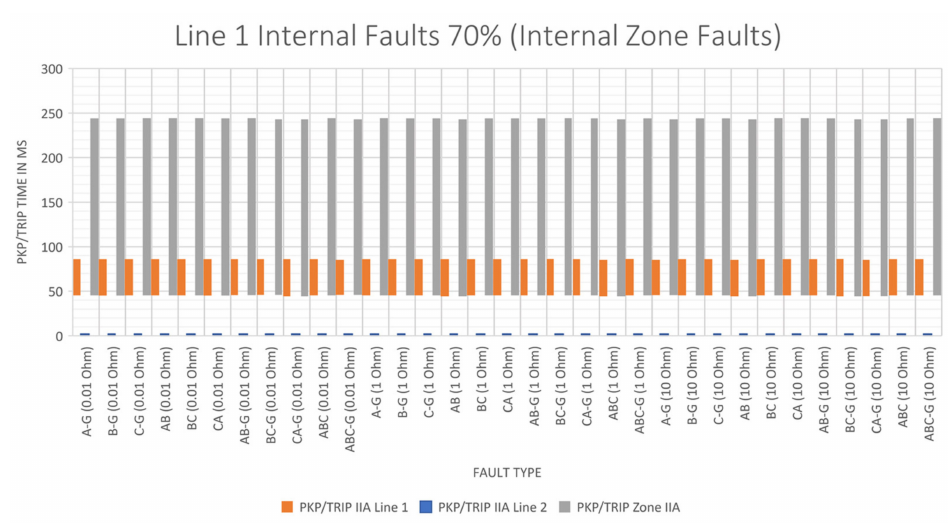
Figure 23. Internal line faults in Line 1 (70%); four